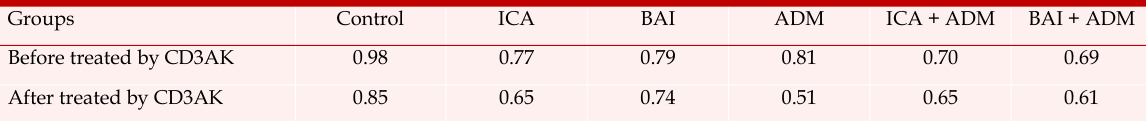
Comparison of the relative mRNA expression level of bcl-2 on HepG2 cells before and after treated by